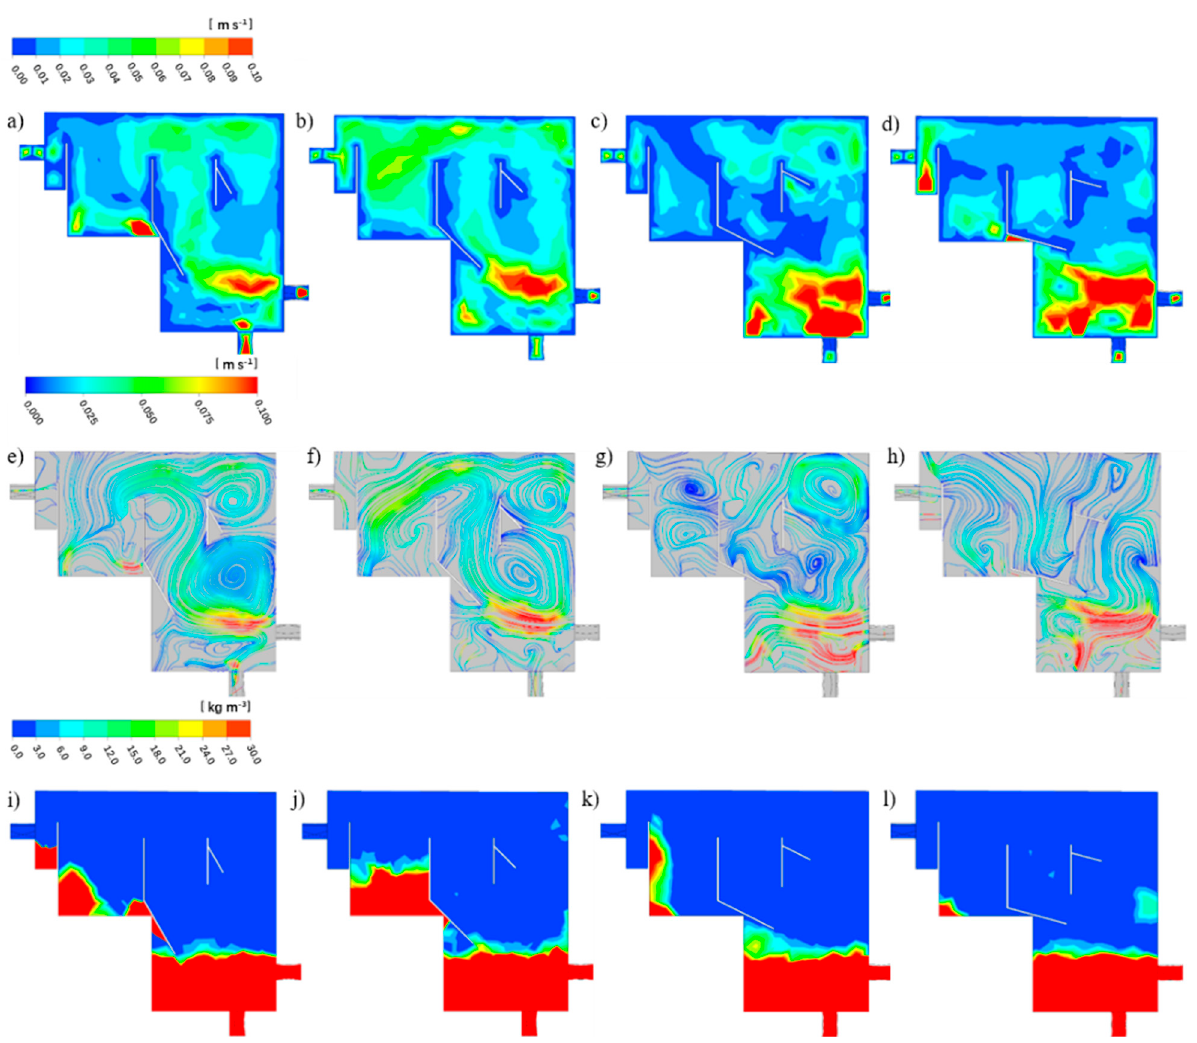
Figure 7. The water velocity contour plots, liquid velocity streamline and the particle distribution contour plots of R3 with the baffle angle of 30° ( a , e , i ), 45° ( b , f , j ), 60° ( c , g , k ) and 75° ( d , h , l ).